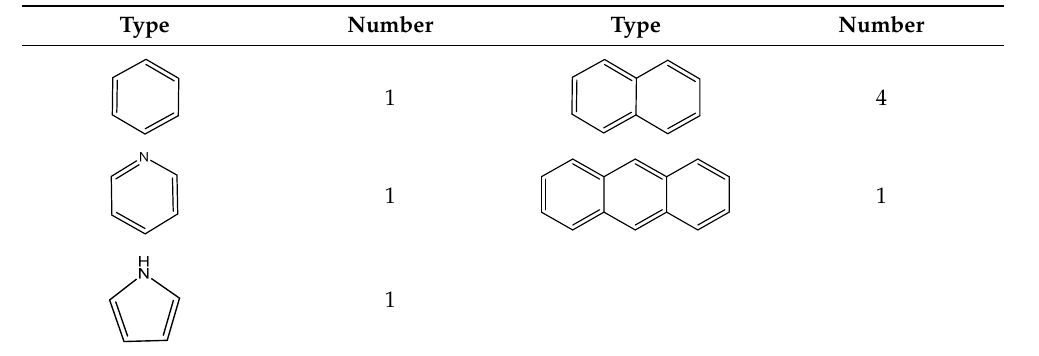
Table 5. Aromatic structure of Kerjian coal.